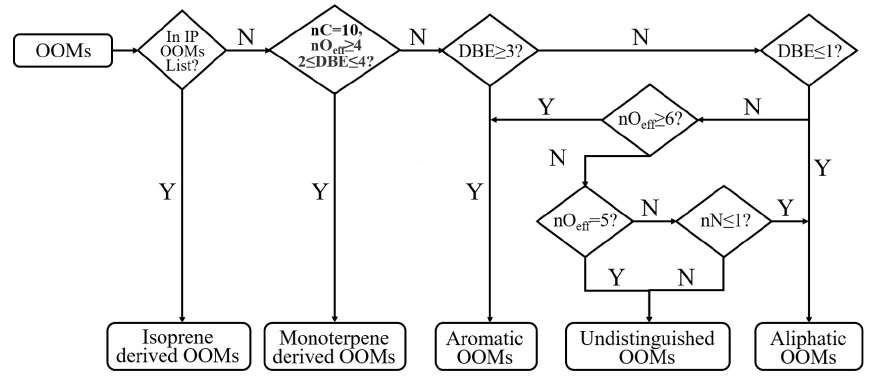
Figure 1. Workflow for retrieving OOM sources. IP OOMs represents isoprene-derived OOMs. nO eff and nN are the numbers of effective oxygen and nitrogen in each OOM molecule, respectively. Y and N denote yes and no,